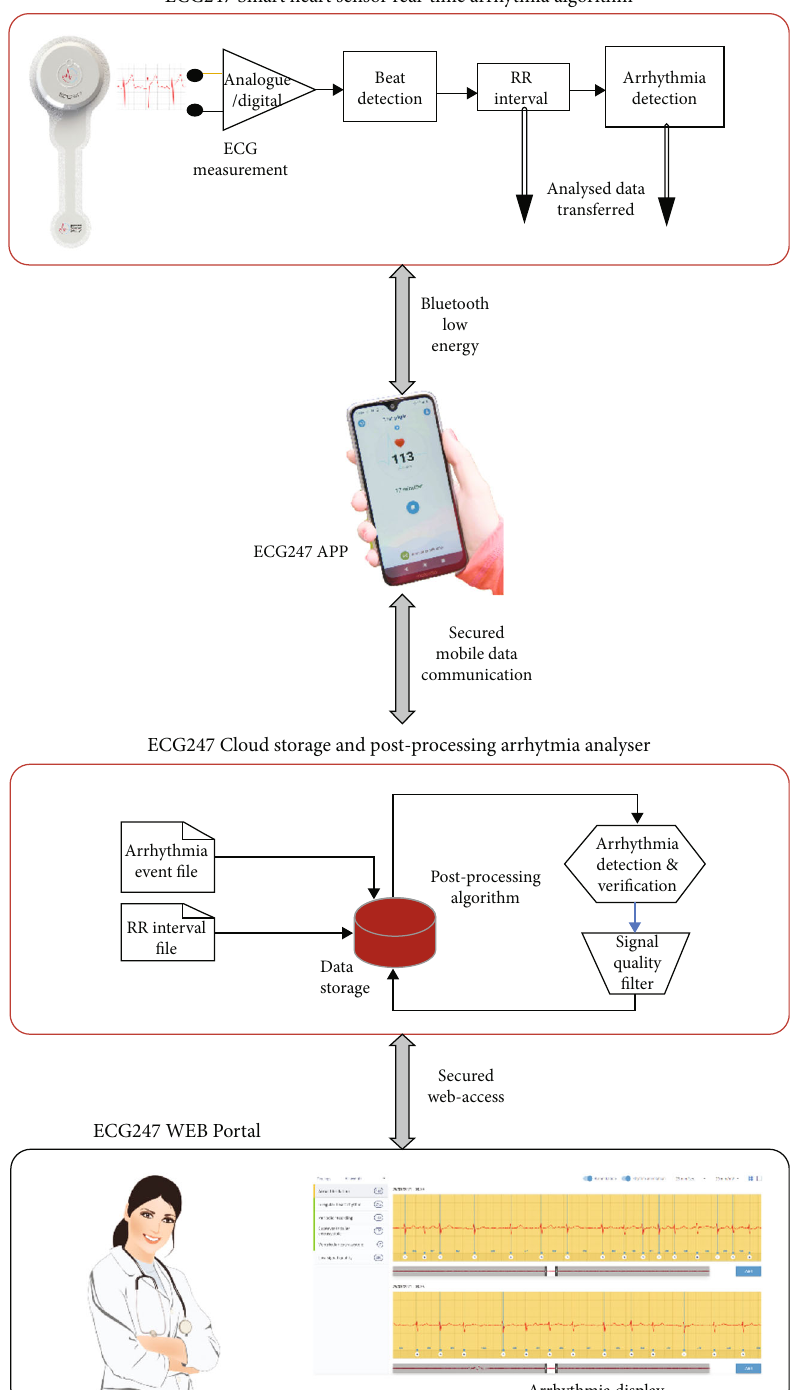
Figure 1: The ECG247 Smart Heart Sensor system: sensor with real-time arrhythmia detection, smartphone application, back-end cloud service with postprocessing arrhythmia analyser, and web